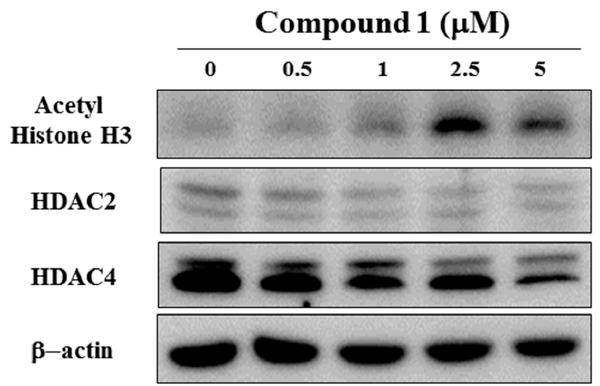
Figure 5. Western blot analysis of the effects of compound 1 on the expression of acetyl histone H3, HDAC2, and HDAC4. MCF-7 cells were exposed to compound 1 at the indicated concentrations for 48 h.